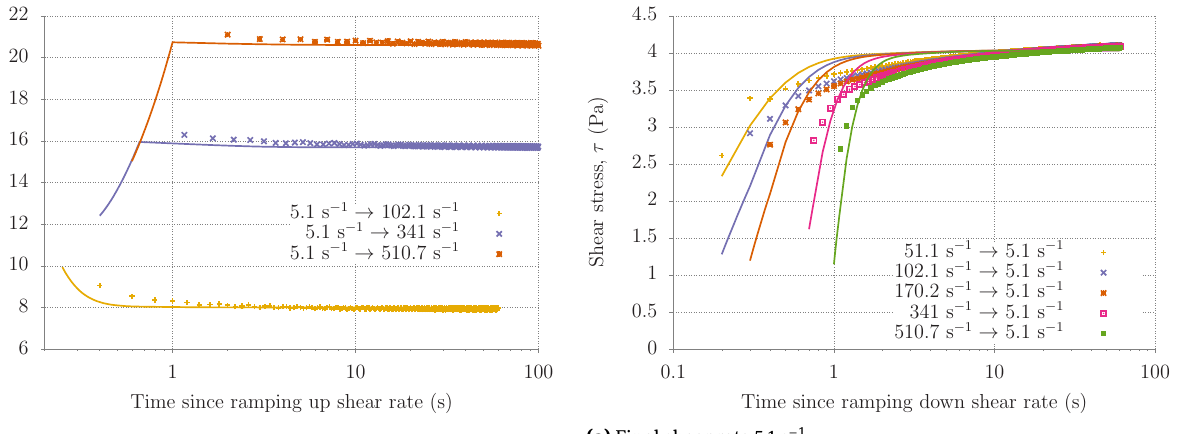
Figure 8: Measurements and model predictions for shear stresses in the OBM following shear rate steps from a shear rate of 5.1 s −1 to different final high shear rates.